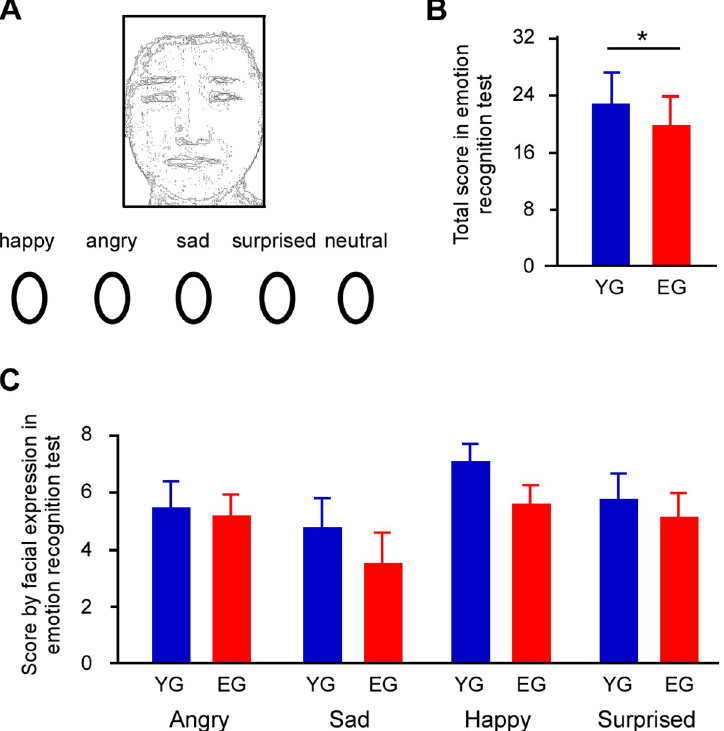
Fig 1. Protocol and results of the emotion recognition test. (A) A representation of a trial. One image of four facial expressions (angry, sad, happy, or surprised) was presented, and the participant was asked to choose a facial expression from five options (angry, sad, happy, surprised, and neutral). The facial picture is illustrated in this paper. (B) The t - test revealed that the total emotion recognition score in the elderly group (EG) was lower than that of younger group (YG). (C) An RM-ANCOVA with years of education and MoCA scores as covariates showed that there was no main effect of facial expression or group, and no interaction. Asterisks indicate significant differences ( p < 0.05). Error bars indicate the standard error of